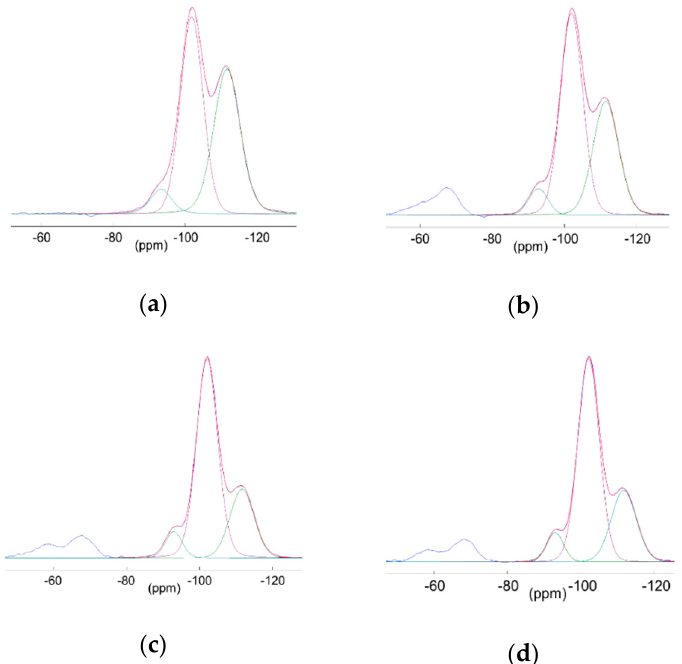
Figure 5. 29 Si CP MAS NMR spectra of SiO 2 ( a ), SiO 2 @NH 2 ( b ), SiO 2 @PW ( c ) and SiO 2 @PMo ( d ).